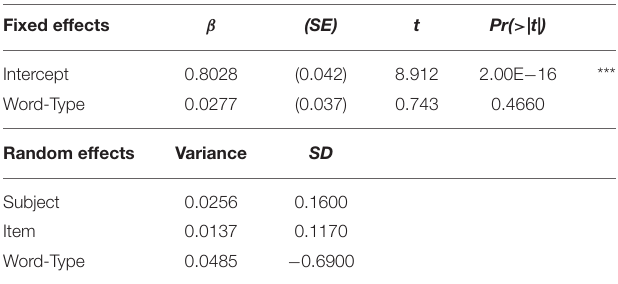
TABLE 7 | L1 meaning accuracy LMER